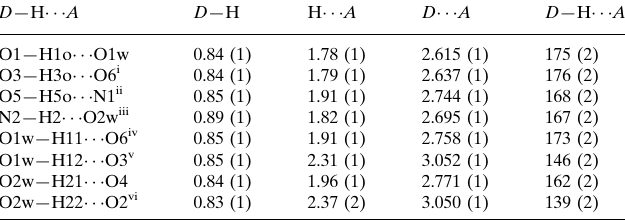
Hydrogen-bond geometry (A˚ , (cid:2)